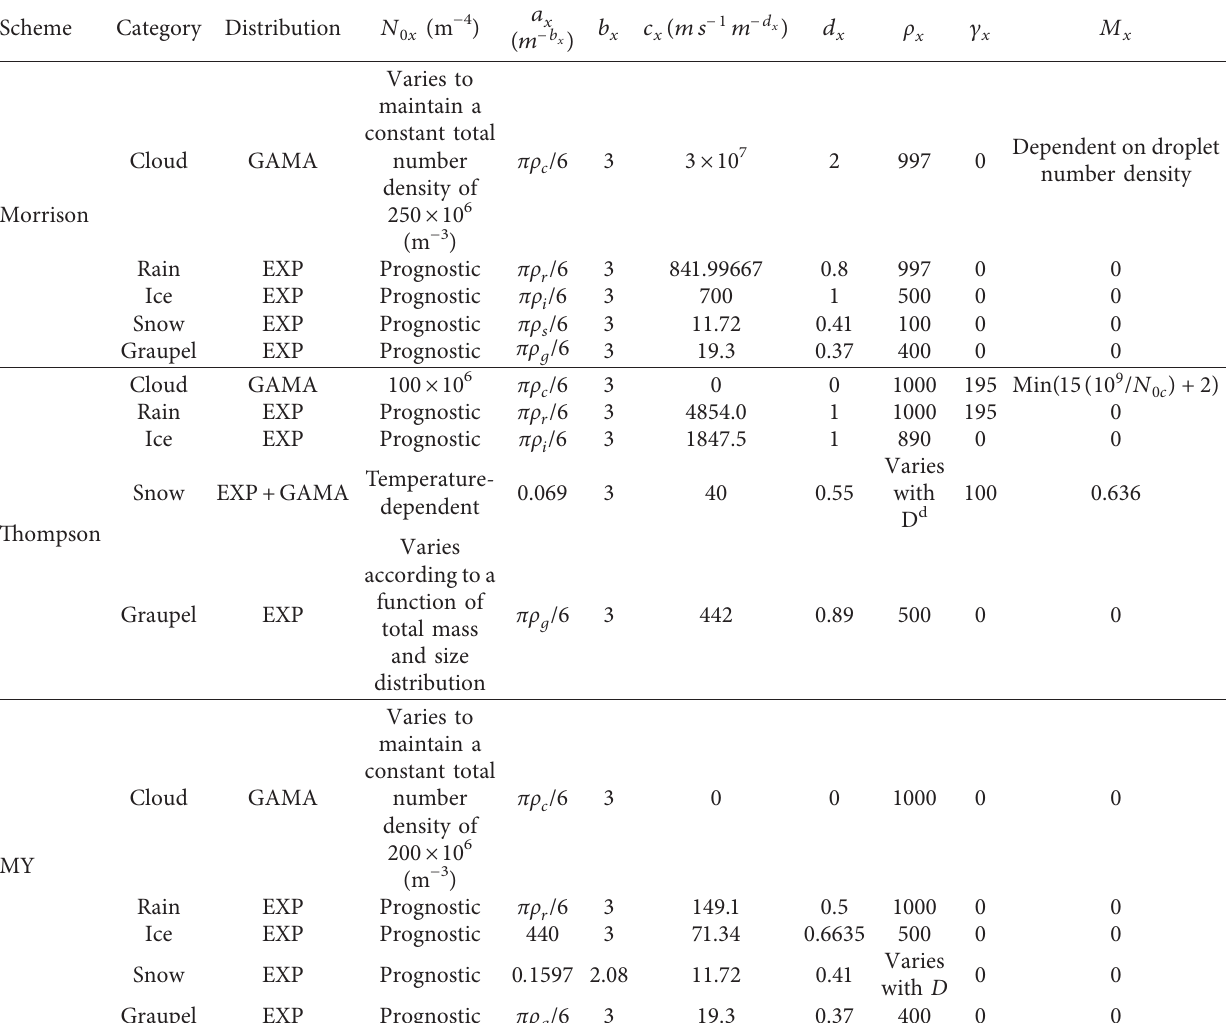
Table 2: Summary of hydrometeor size distributions in the Morrison, Thompson, and MY